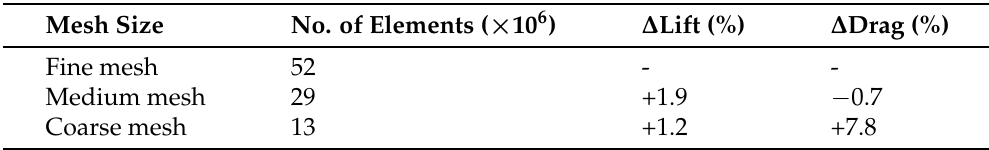
Table 1. Mesh resolution study for the isolated rotor head.